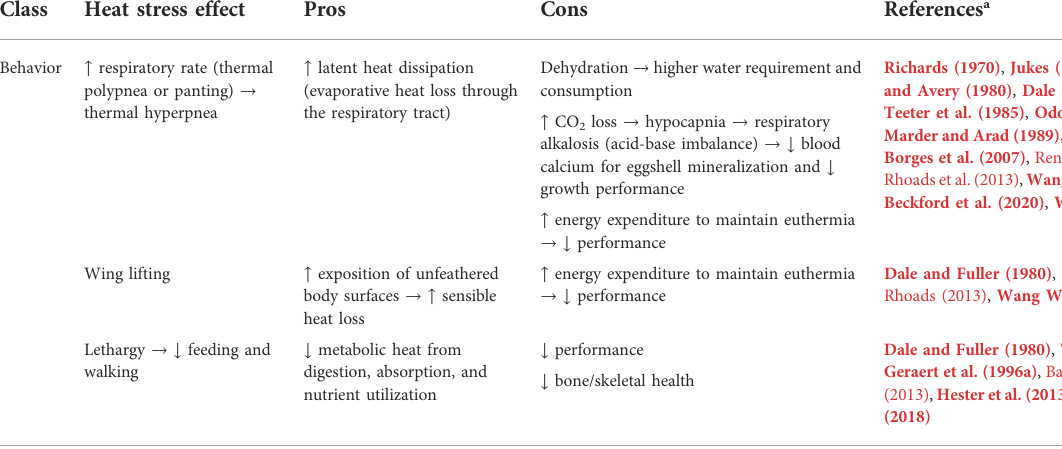
Upward arrow ( ↑ ), increase; downward arrow ( ↓ ), decrease; rightward arrow ( → ), consequence/degeneration. a Include studies on non-avian species that have exhibited comparable heat stress effects and responses to those observed in chickens. Studies with the focus on chickens or poultry are highlighted in bold.